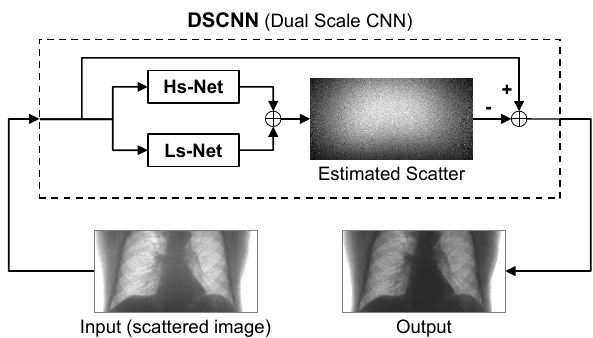
Figure 2. Test process of the proposed scatter correction method.